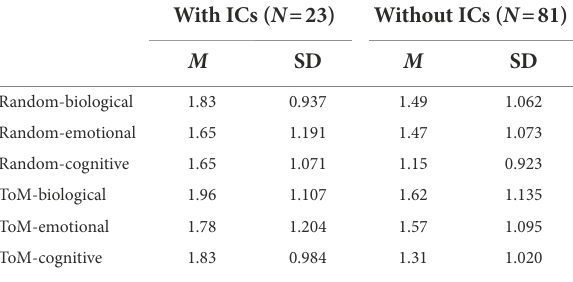
TABLE 1 Mean and standard deviation of agency attributions to ToM and random animations for imaginary companion status.